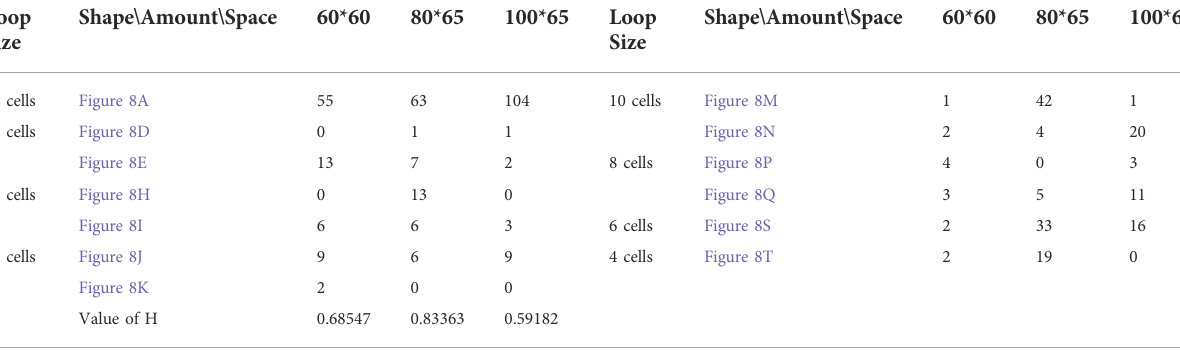
TABLE 2 Statistical numbers of the loops with various structures for the greedy selection mechanism on different cellular spaces starting from the initial con fi guration in Figure 7A. Loop Shape ∖ Amount ∖ Space Size